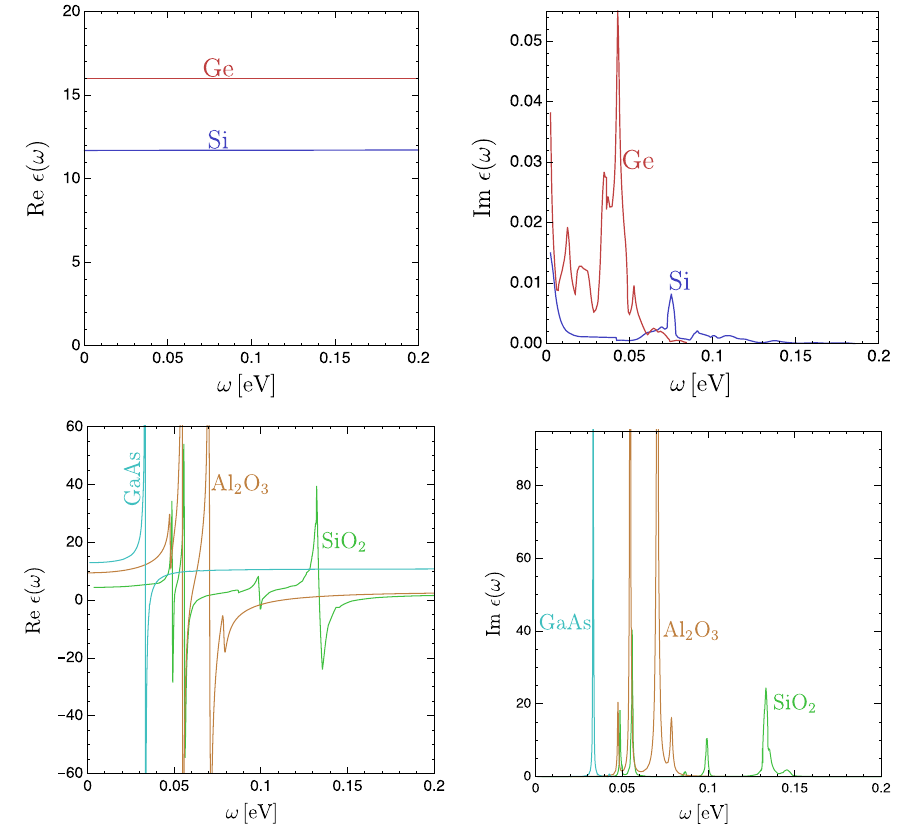
FIG. 2. Real and imaginary parts of the dielectric functions of Ge and Si (top) and of the polar materials α -quartz, sapphire, and GaAs (bottom), in the range of photon energies 0 ≤ ω ≤ 0 . 2 eV. For the case of sapphire and α -quartz, which are optically anisotropic materials, we show only the dielectric function for the ordinary ray, with polarization perpendicular to the optical axis. All data are presented at room temperature. Data for Si are obtained from Refs. [114,115], for Ge from Refs. [114,116], for α -quartz from Refs. [114,117], for sapphire from Ref. [118], and for GaAs from Ref.